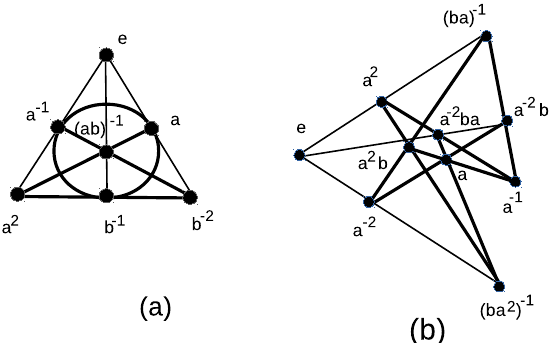
Figure 6. Contextual geometries associated to (i) true and (ii) false for the MICs of the figure-eight knot K 4 a 1 listed in Table 1. ( a ) The Fano plane related to the manifold otet14 00002 at index 7, and ( b ) the Desargues configuration [ 10 3 ] at index 10. The bold lines are for cosets that are not all mutually commuting. Each line corresponds to pair of cosets with the same stabilizer subgroup isomorphic to Z 2 .